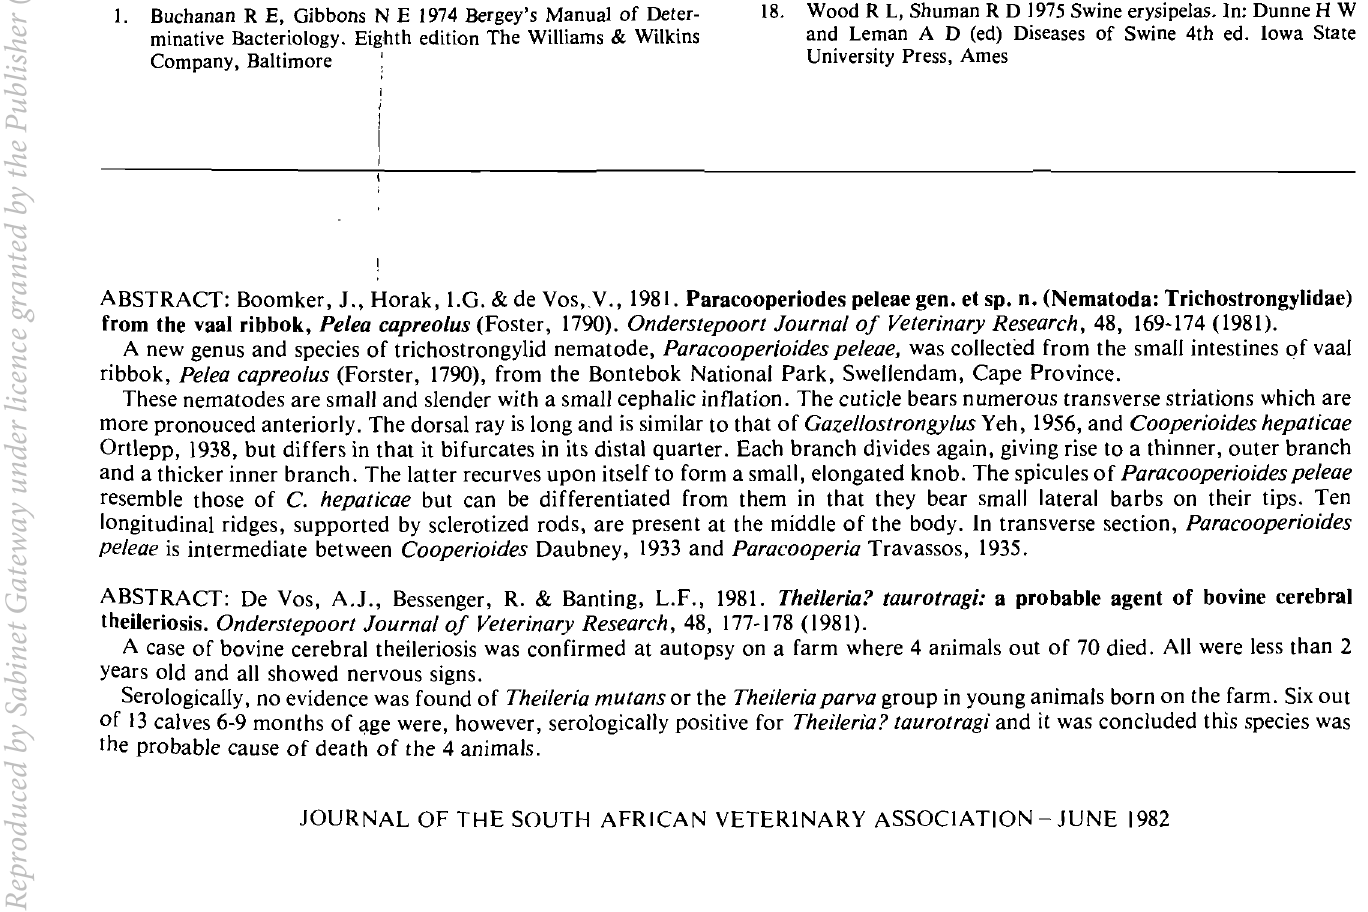
Table 1: RESULTS OF MICROBIOLOGICAL EXAMINATION OF ARTHRITIC PORCINE